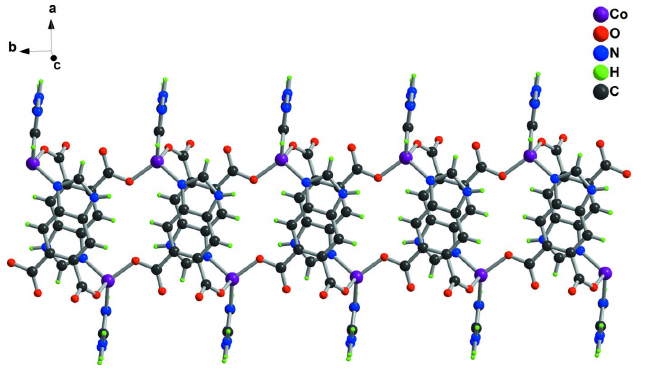
Figure 2 A view of the one-dimensional straight chain structure within the coordination polymer.